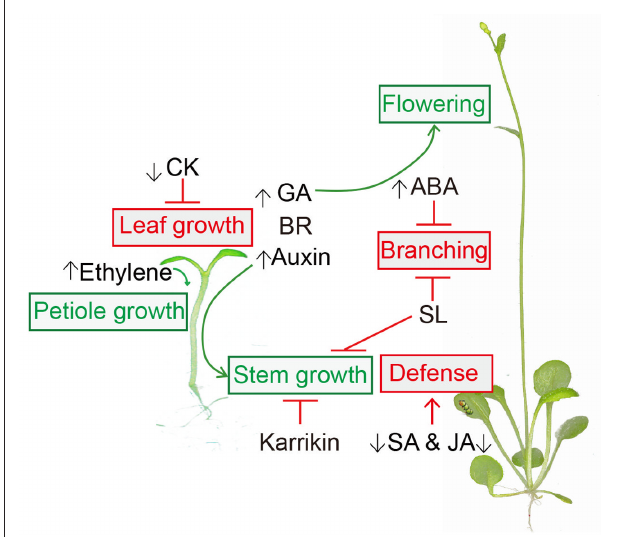
FIGURE 1 | Hormonal regulation in shade avoidance. Auxin, Gibberellin (GA), Brassinosteroid (BR), Karrikin and strigolactone (SL) are involved in shade-regulated stem growth. Ethylene is required for shade-induced petiole elongation. Shade-reduced cytokinin (CK) inhibits the leaf growth. Shade light also represses salicylic acid (SA) and jasmonic acid (JA) mediated defense. Abscisic acid (ABA) and SL suppress branching in shade. GA contributes to shade-induced early flowering. Shade-stimulations are presented in green and shade-supressions are presented in